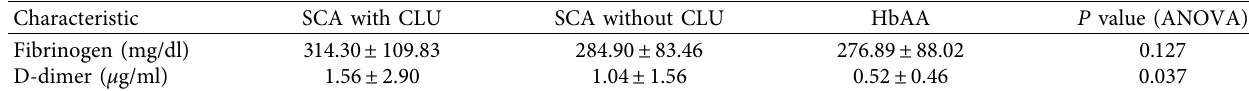
Table 3: Levels of fibrinogen and D-dimers among study